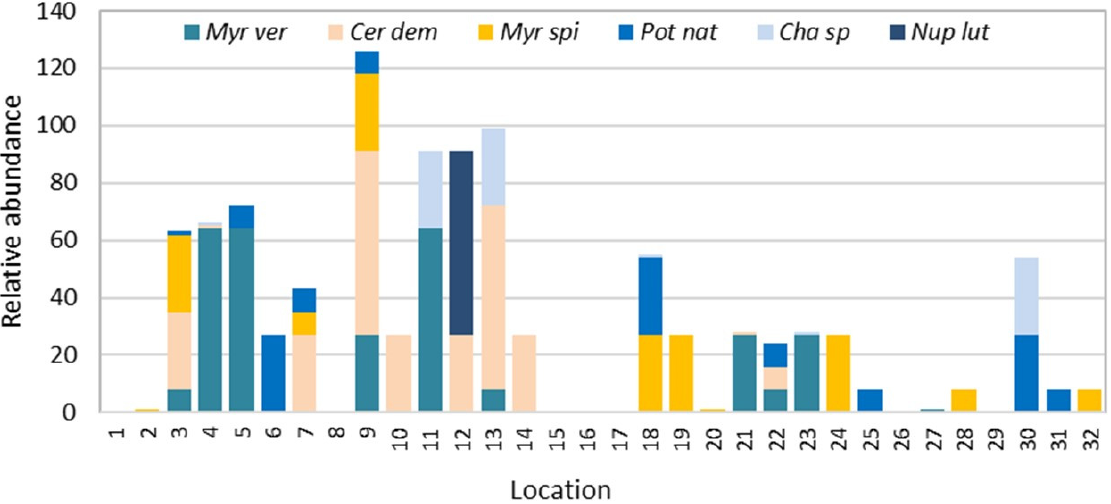
Figure 4. Relative abundance of native hydrophyte species with total abundance more than 2% present in surveyed waterbodies: Myr ver—Myriophyllum verticillatum , Cer dem — Ceratophyllum demersum , Myr spi — Myriophyllum spicatum , Pot nat — Potamogeton natans , Cha sp— Chara species, Nup lut — Nuphar luteum .